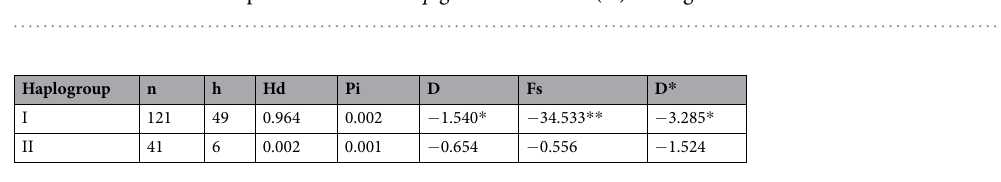
Table 4. Number of haplotype (h), haplotype diversity (Hd), nucleotide diversity (Pi), Tajima’s D (D), Fu’s Fs (Fs) and Fu & Li’s D * (D * ) tests based on haplogroups of Haematobia exigua . * P < 0.05, ** P < 0.001.